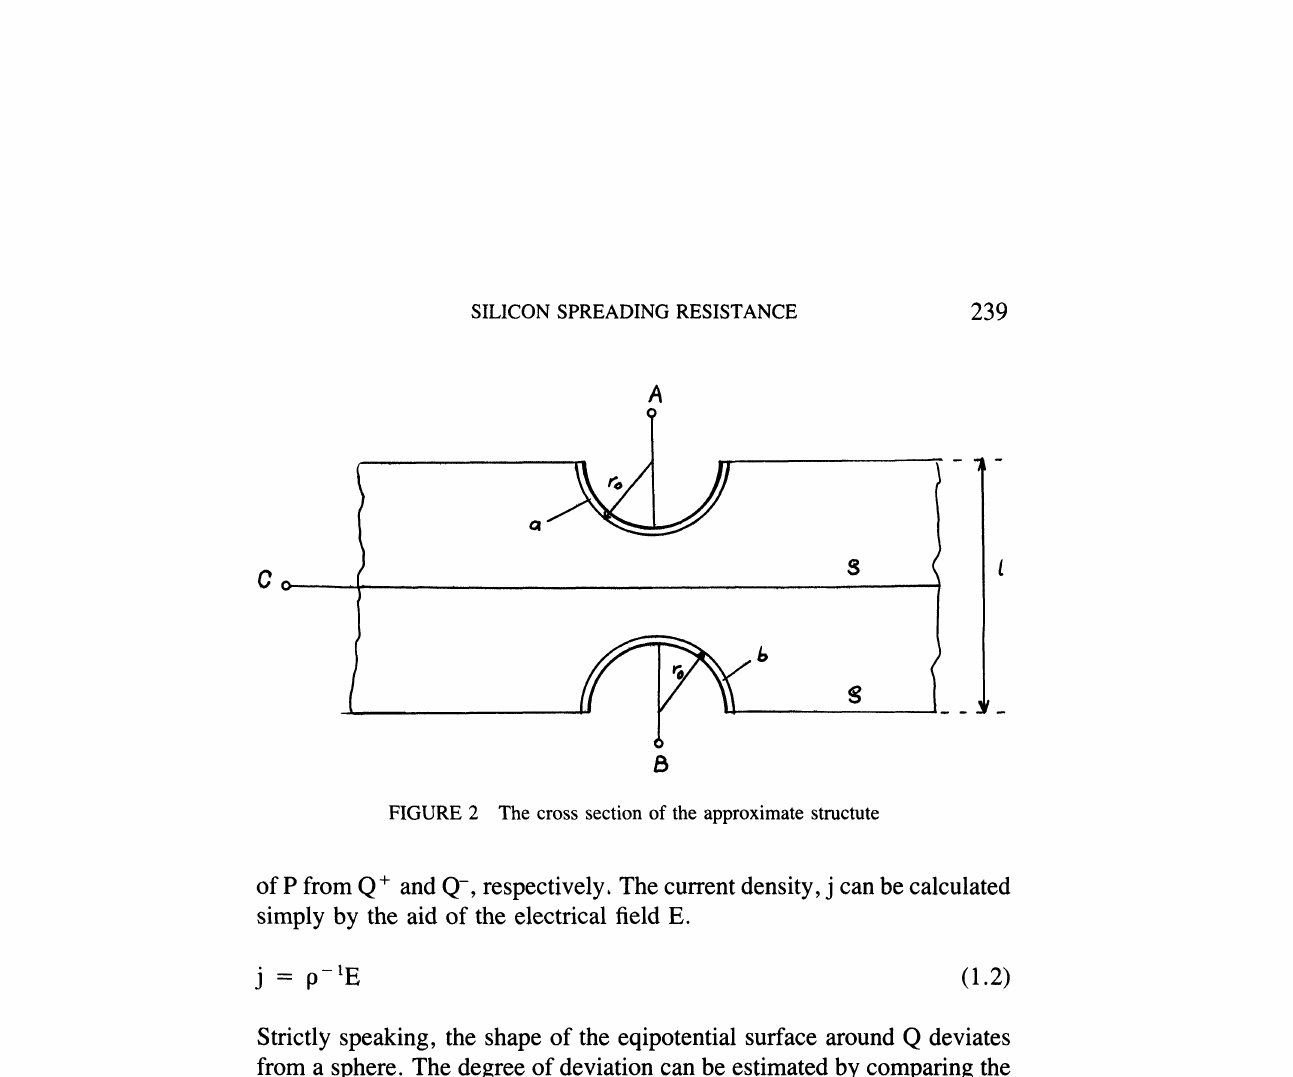
FIGURE 2 The cross section of the approximate